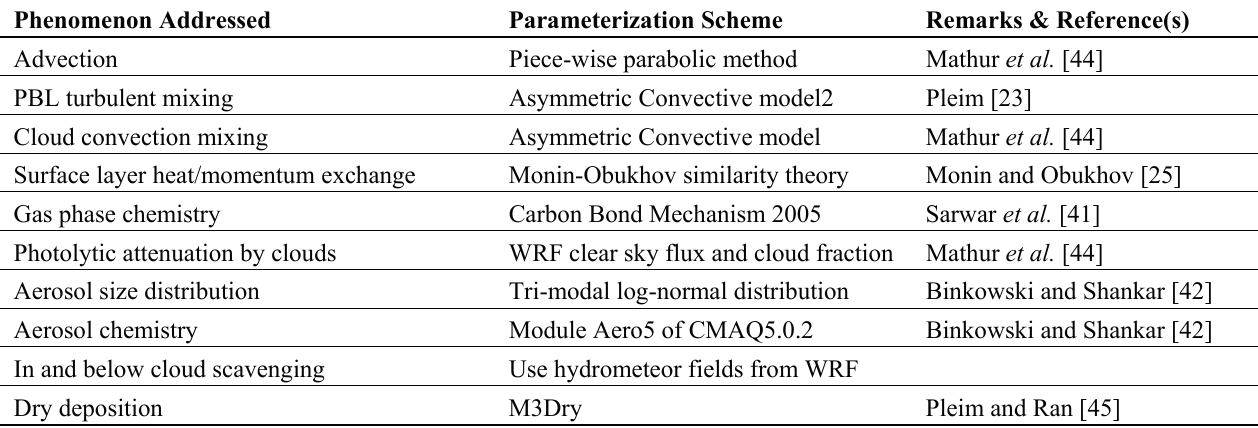
Table 2. CMAQ version 5.0.2 chemistry and physics